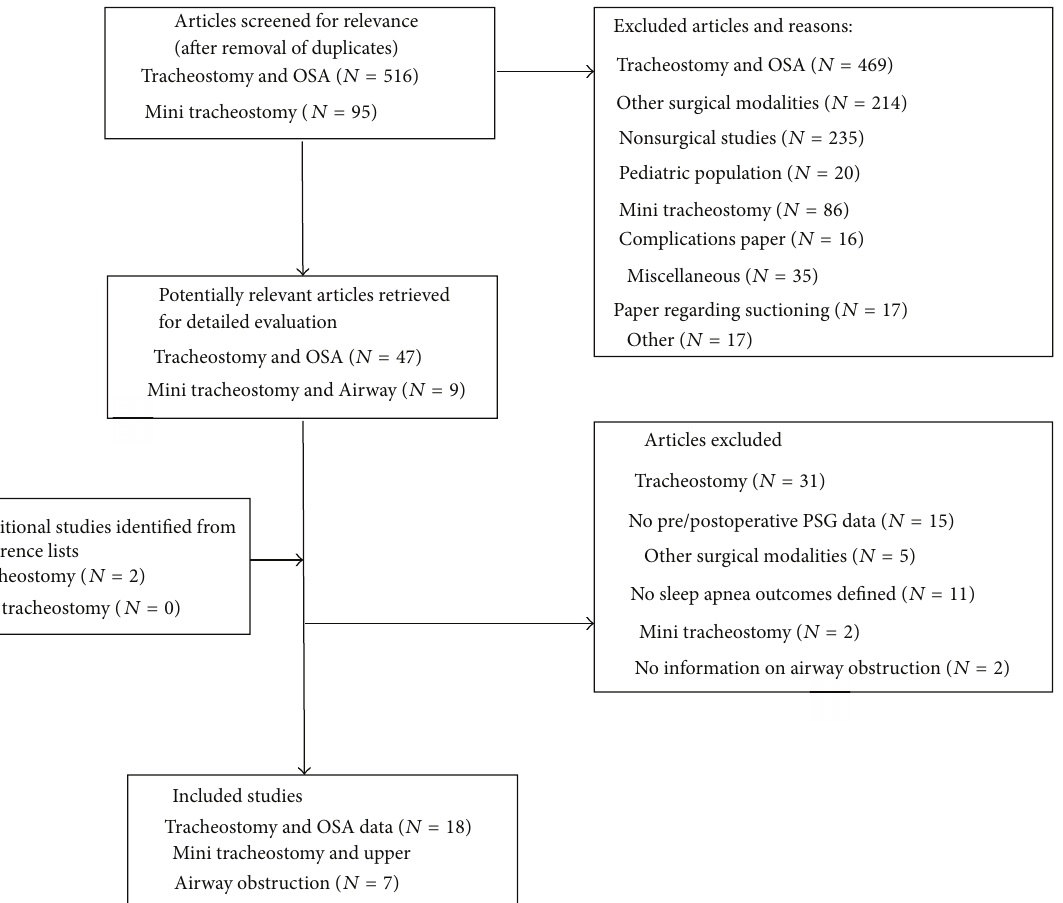
Figure 1: Flow diagram for tracheostomy studies and mini tracheotomy studies. 𝑁 : number of